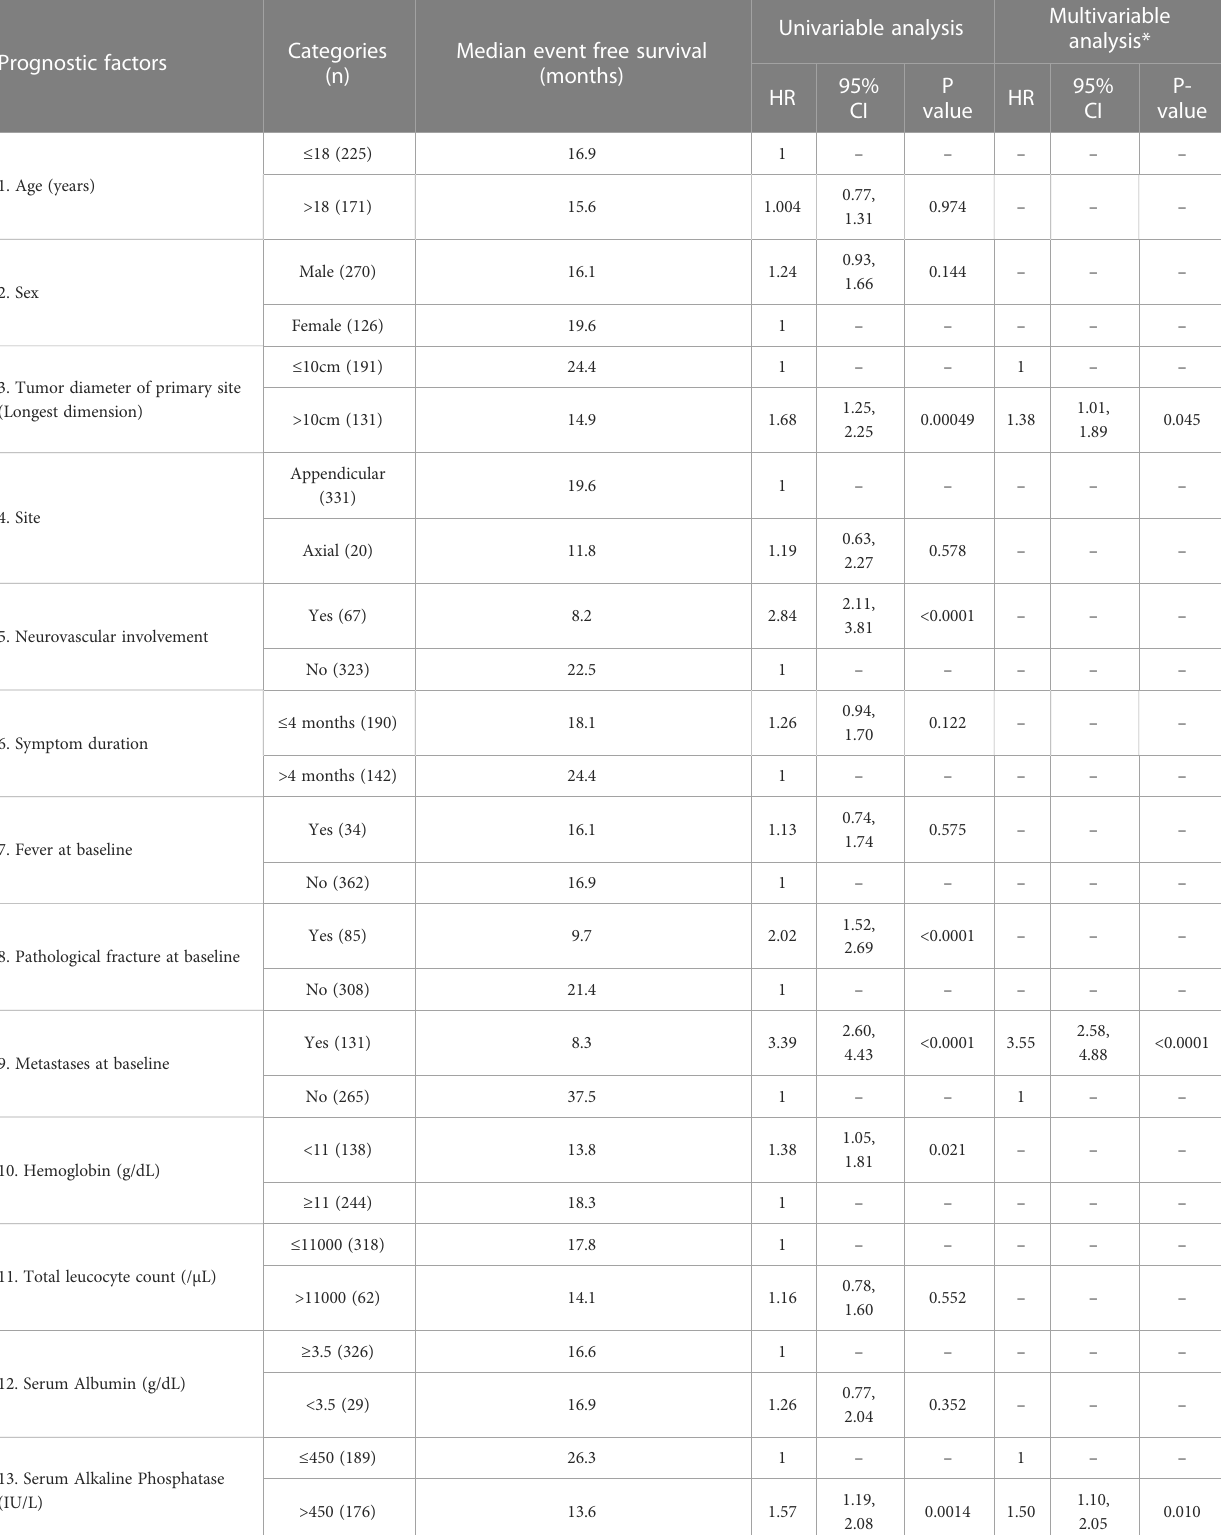
TABLE 2 Univariable and multivariable analyses of prognostic factors for event free survival in the derivation cohort